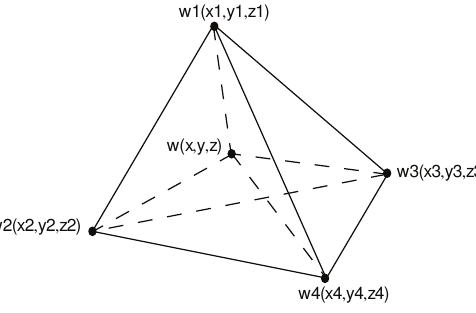
Figure 1. A tetrahedral element. Computing 3D shape functions by tetrahedral volume divisions. w 1 , w 2 , w 3 and w 4 are measured values, while the value w at the location ( x , y , z ) is unknown and needs to be